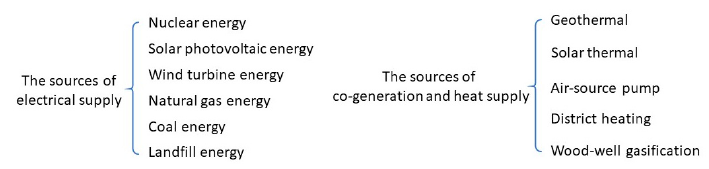
Figure 1. The sources of electrical and heating supply.